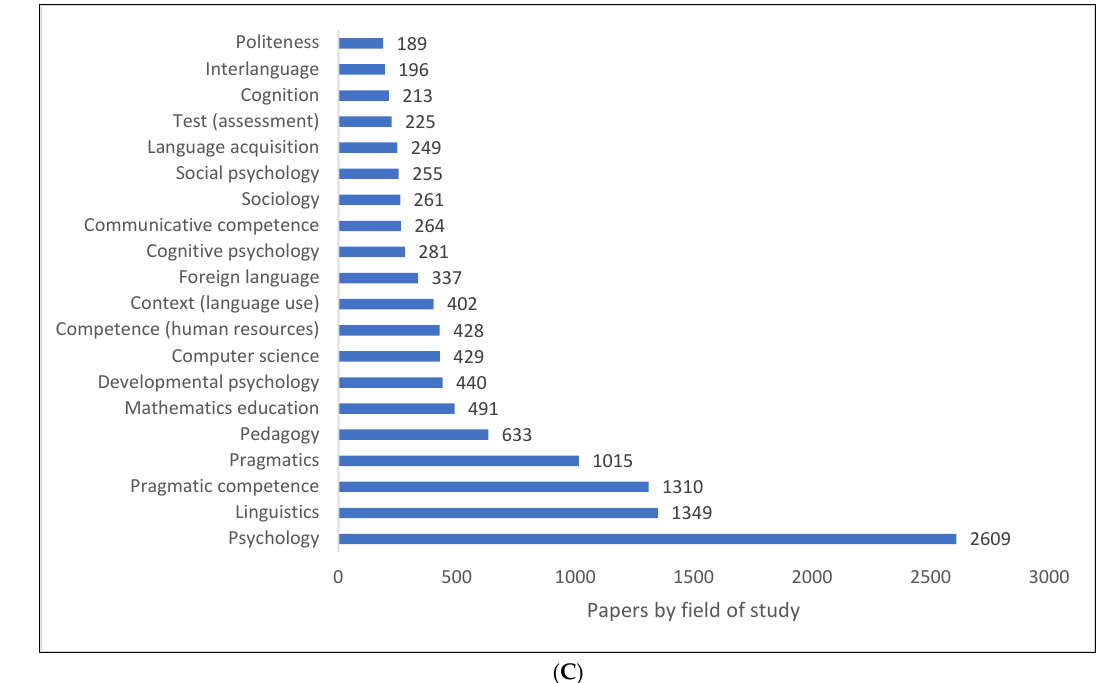
Figure 6. Pragmatic language development knowledge production size by research area: ( A ) Scopus; ( B ) WOS; ( C ) Lens.